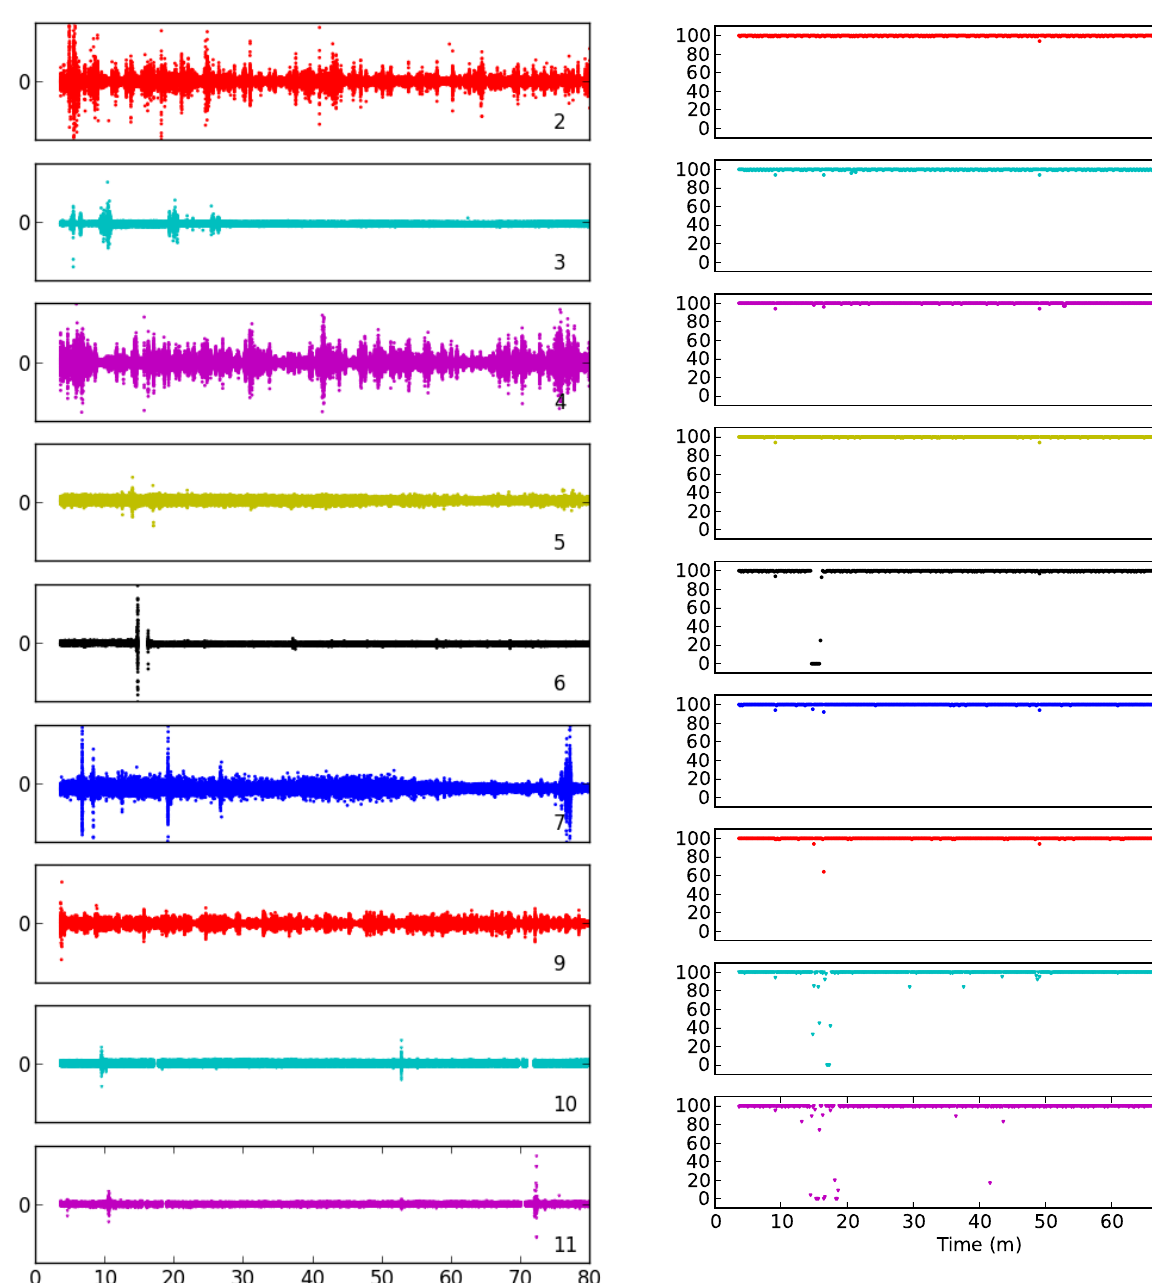
Figure 25. Percentage of received samples over 10s intervals. Fig. 25: Percentage of received samples over 10s intervals The test lasted a little over 3 h. It was conducted between 15:00 and 18:00 GMT. At the end of the test, all nodes were collected. This procedure required roughly half the time the deployment had taken, when it was necessary to wait for the GPS to acquire a lock. When performing this procedure, we detected another problem in the system design. There is no external button on the exterior of the case to shut down the equipment orderly. For this reason, as the various nodes